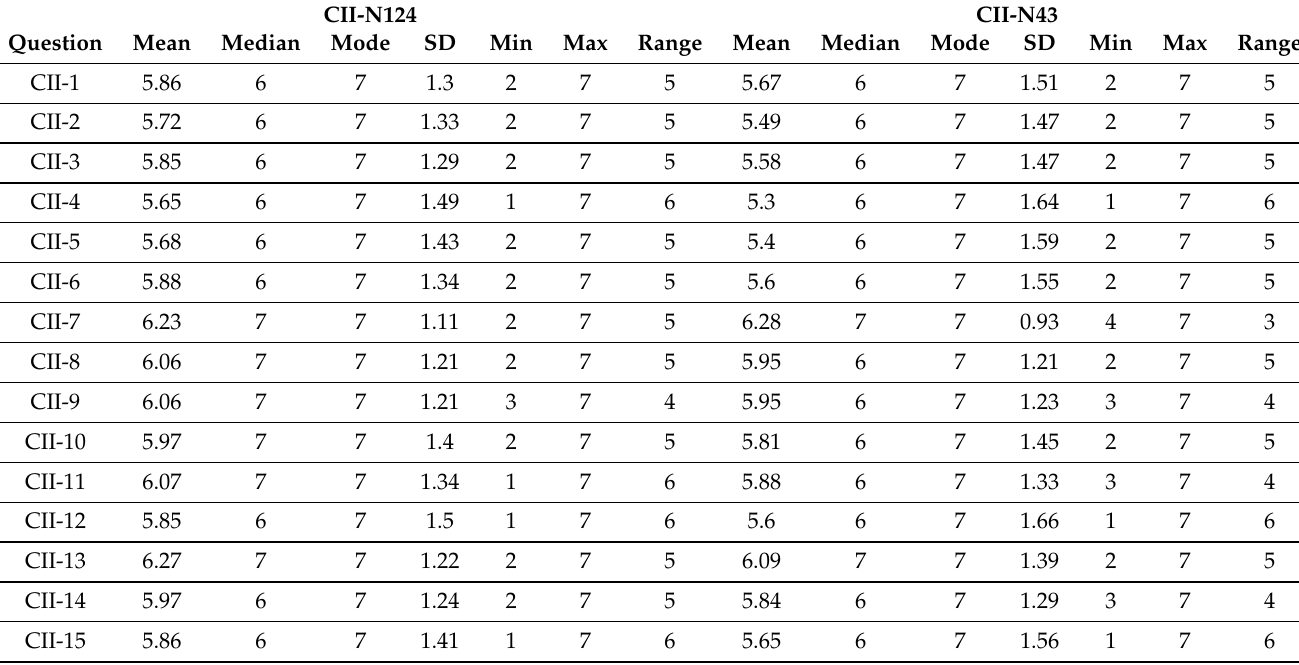
Figure 15. Mean response with standard deviation for the CII-N124 and CII-N43 results. Table 6. The statistical analysis of the CII quantitative questions. CII-N124